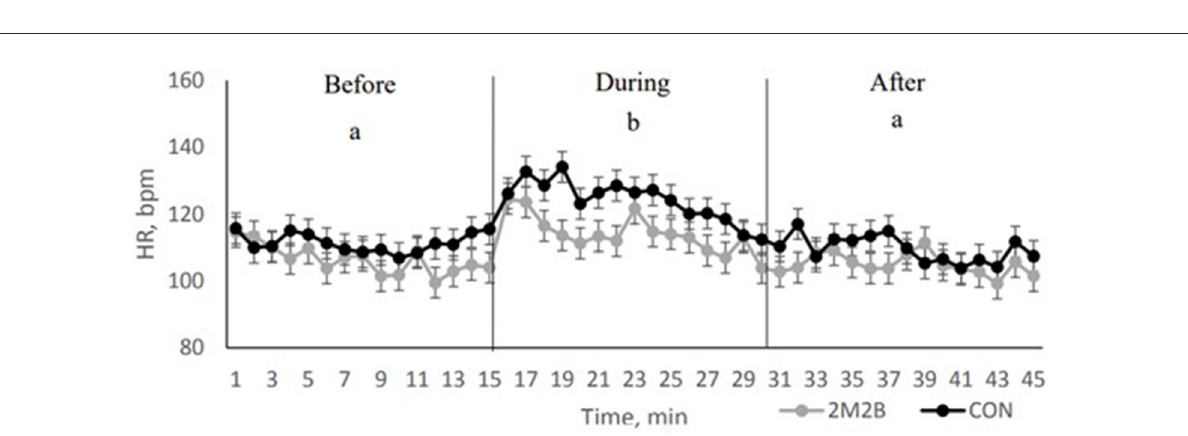
FIGURE2 Dog heart rate when dogs either had a control or 2M2B treatment before during and after a simulated thunderstorm. Each data point represents 19 dogs. Note that dogs with 2M2B therapy had significantly lower heart rate than control dogs (or the rise in HR was blunted). Adapted from Pirner (28). Before is immediately before the loud thunderstorm. Note that control dogs increase in HR at time zero and remain elevated during the trip. This is an objective demonstration of a calming